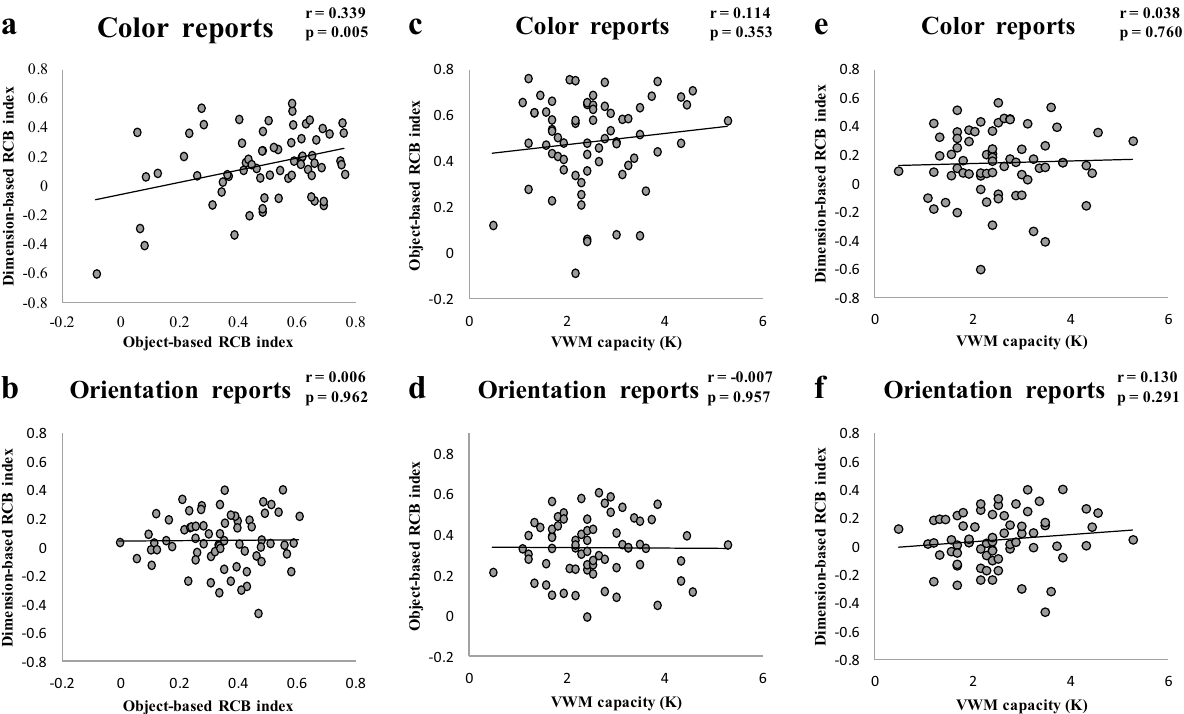
Figure 5. Scatter plots for the correlations between object-based RCB index, dimension-based RCB index, and VWM capacity. ( a ) Correlation across participants between object-based RCB index and dimension-based RCB index for color report trials. ( b ) Correlation across participants between object-based RCB index and dimension-based RCB index for orientation report trials. ( c ) Correlation across participants between VWM capacity (K) and RCB index for the color report trials for the object-based cue task. ( d ) Correlation across participants between VWM capacity and RCB index for the orientation report trials for the object-based cue task. ( e ) Correlation across participants between VWM capacity and RCB index for the color report trials for the dimension-based cue task. ( f ) Correlation across participants between VWM capacity and RCB index for the orientation report trials for the dimension-based cue